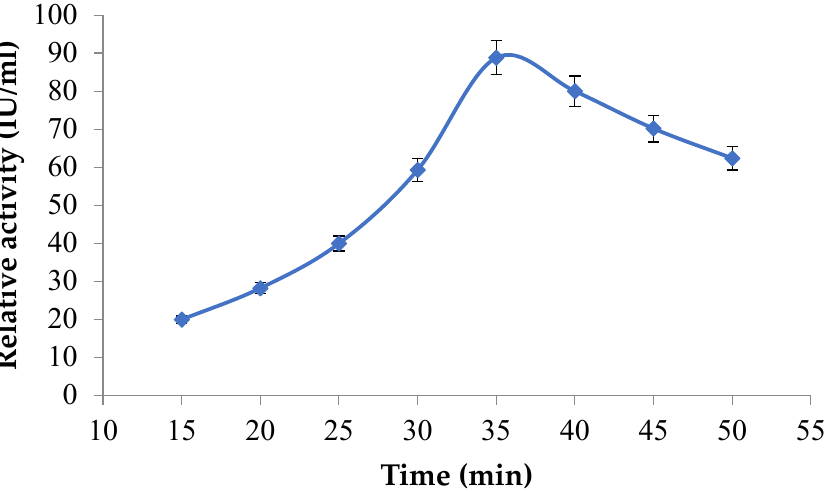
Figure 5. Effect of induction period on protease activity.